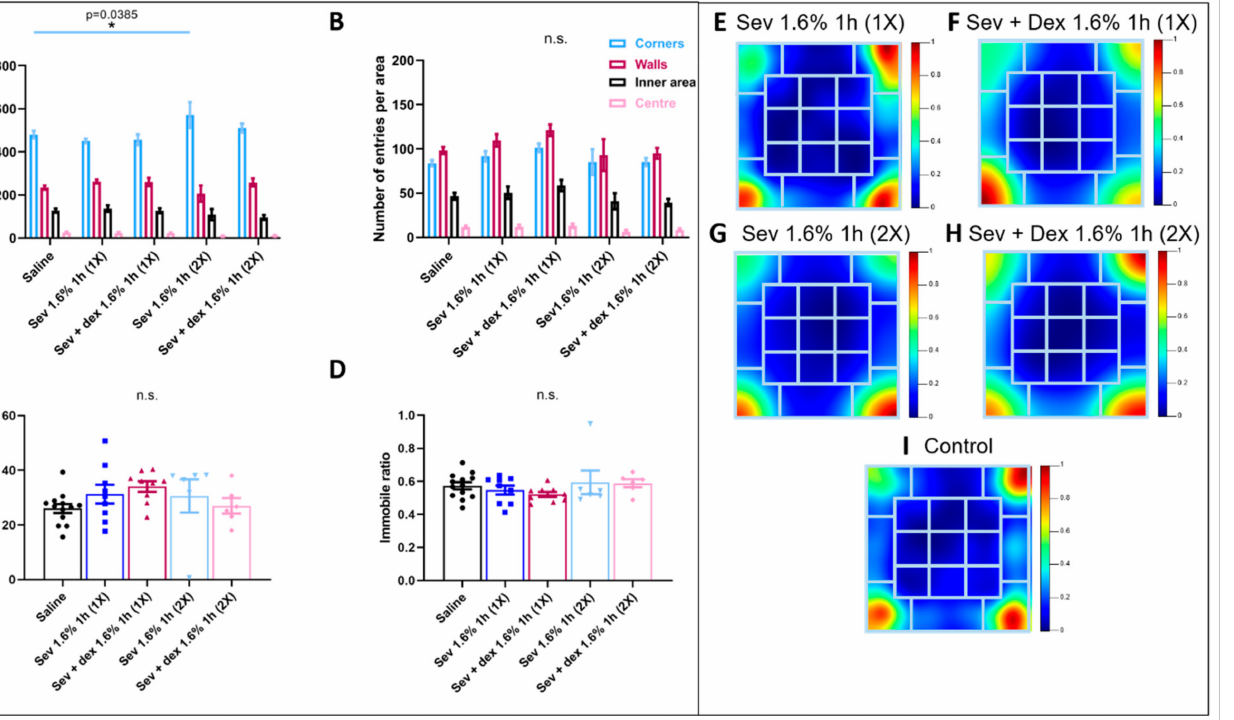
Figure 2. DEX pre-treatment decreased anxiety and increased willingness to explore during open field testing. Representation of ( A ) time spent in each area, ( B ) number of entries in each area, ( C ) total distance travelled, ( D ) immobile ratio, and heatmaps representing the average time spent in each area of the box in ( E ) sevoflurane 1.6% 1 h (1 × ) animals, ( F ) Sev + Dex 1.6% 1 h (1 × ) animals, ( G ) sevoflurane 1.6% 1 h (2 × ) animals, ( H ) Sev + Dex 1.6% 1 h (2 × ) animals, and ( I ) control animals (saline) (dark blue—less time, dark red—more time). Bars are mean ± SEM ( A ) F (12,152) = 2.440, * p = 0.0385 and ( B ) F (12,152) = 0.6265, p = 0.8173 using two-way ANOVA with Tukey’s post hoc analysis for multiple comparisons and ( C ) F (4,38) = 1.388, p = 0.2565 and ( D ) F (4,36) = 1.022, p = 0.4089 using one-way ANOVA with Dunnett’s post hoc analysis for multiple comparisons. n = 13 for control, n = 9 for Sev and Sev + Dex 1.6% 1 h (1 × ) and n = 6 for Sev and Sev + Dex 1.6% 1 h (2 ×